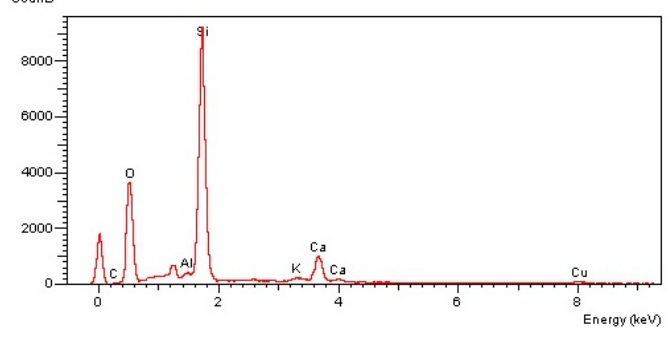
Figure 10. EDX graph of coating.